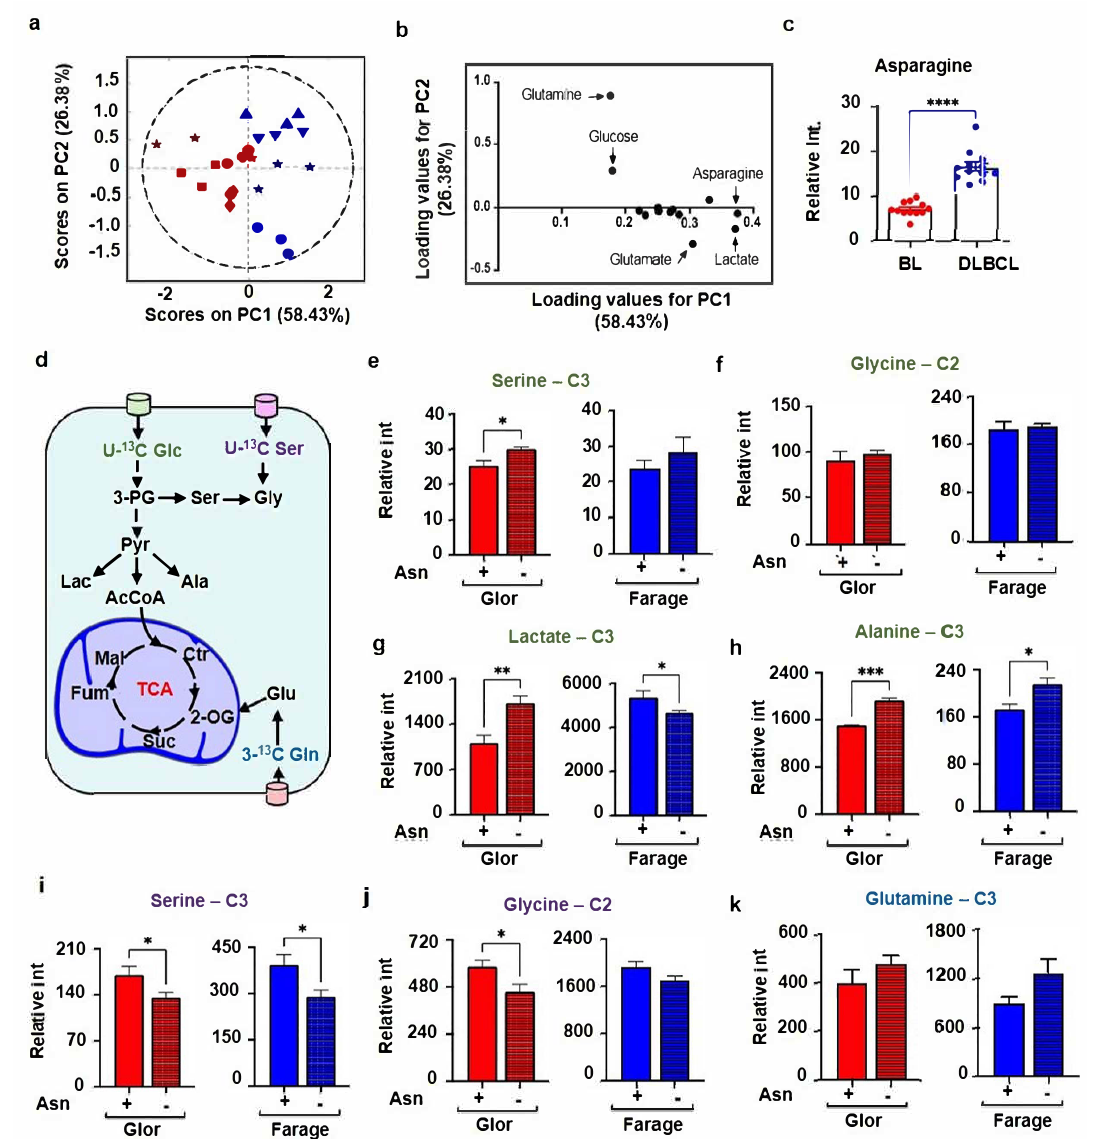
Figure 1. Regulation of intracellular metabolism by exogenous asparagine. ( a ) Principal Component Analysis (PCA) for 1D 1 H-NMR for media samples using a metabolite data matrix consisting of 13 metabolites in the spent media of Sav, Glor, Ezema, BL31 representing BL (red) and Farage, SUDHL4, SUDHL5 and SUDHL6 cells representing DLBCL (blue). ( b ) Representation of corresponding loadings plot. ( c ) Comparison of 1D 1 H-NMR peak intensities of asparagine at 2.80 ppm for the media samples of DLBCL and BL cells line cells. ( d ) Simplified illustration of metabolism of the labelled precursors [U- 13 C] glucose, [U- 13 C] serine and [3- 13 C] glutamine ( e – k ). 13 C peak intensity of the metabolites derived from either [U- 13 C] glucose labelled media ( e – h ) or [U- 13 C] serine and [3- 13 C] glutamine labelled media ( i – k ) in the absence or presence of asparagine for 24 h. The confidence ellipse in the PCR score plot is based on 95% confidence. Bar graphs represent mean ± SEM, with n = 3. Data are shown as * p < 0.05; ** p < 0.01; *** p < 0.001, **** p <